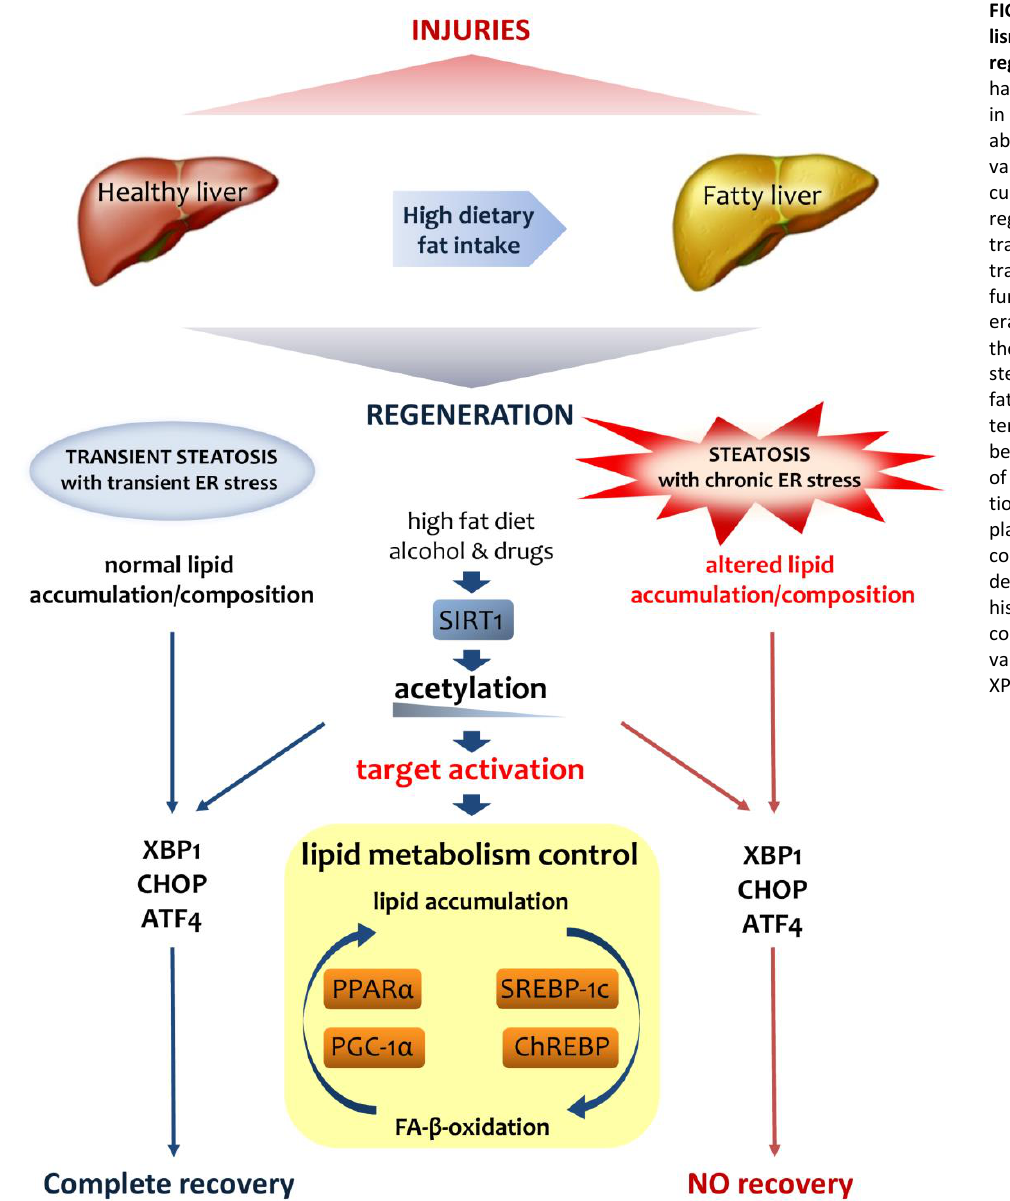
FIGURE 3: Lipid metabo- lism is crucial for liver regeneration. Fatty